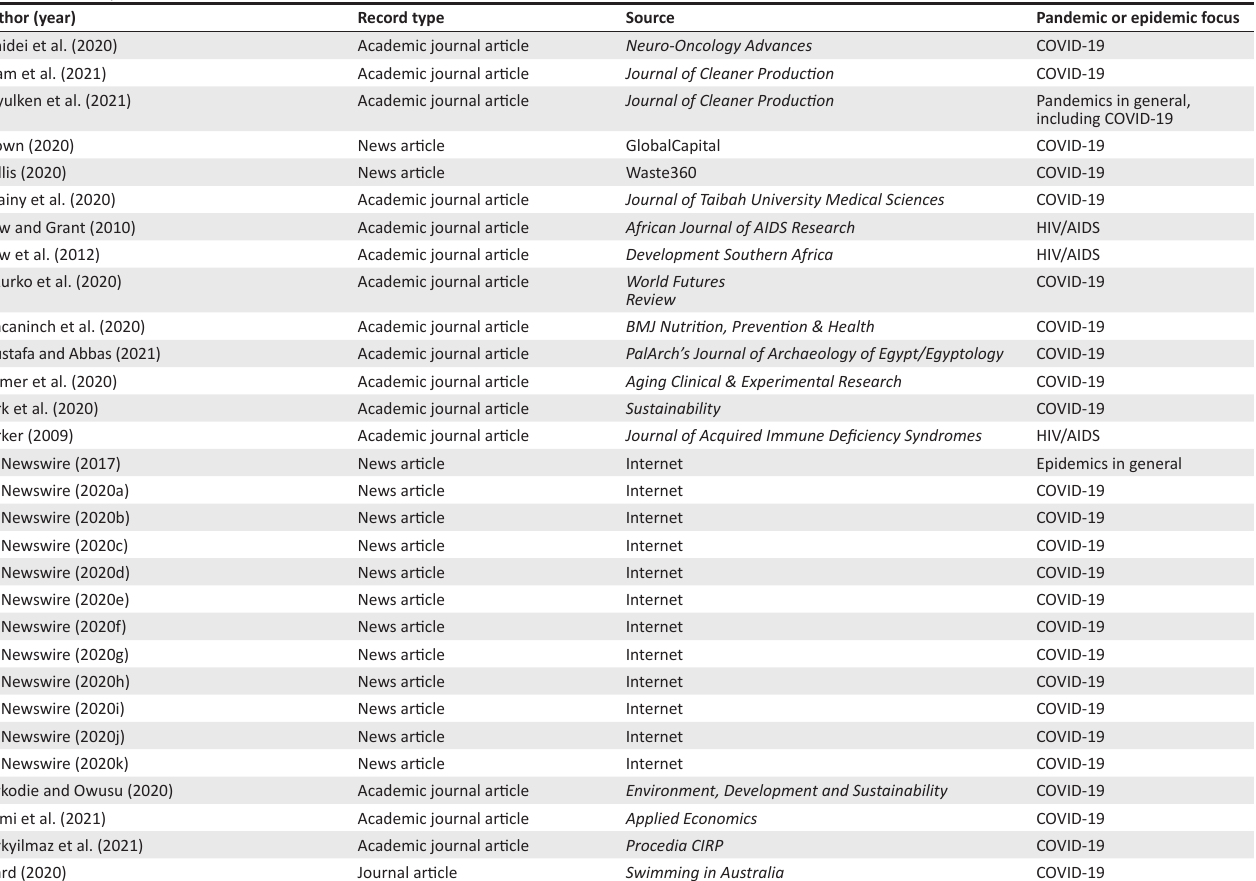
TABLE 1-A1: Complete list of 30 articles